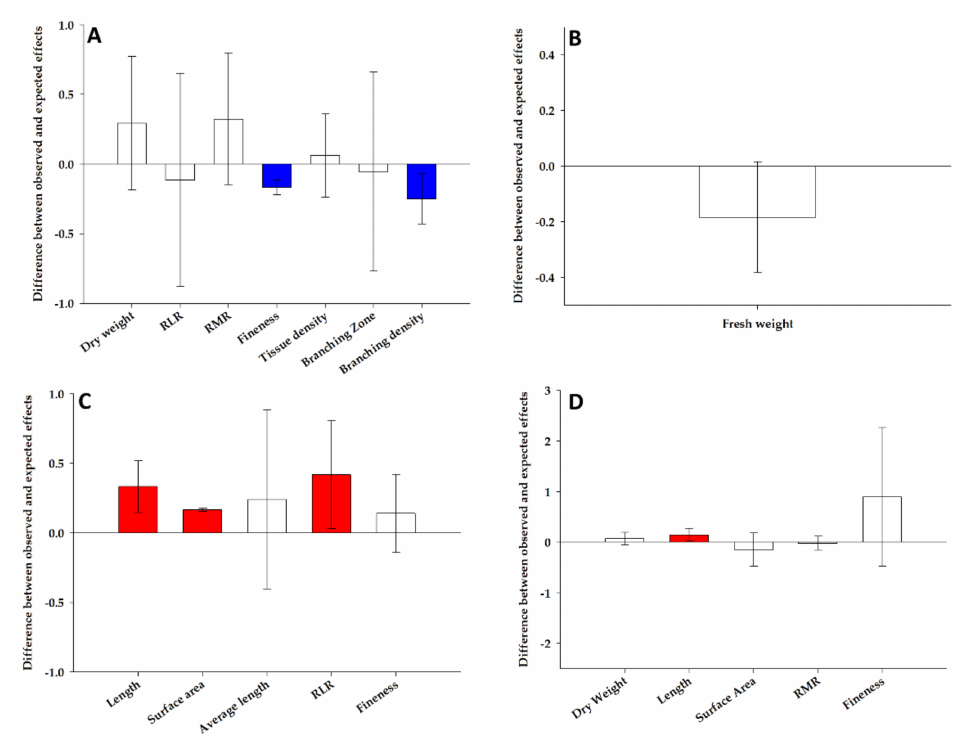
Figure 3. The combined impacts from drought and heat stress on selected traits of root primary ( A ), seminal ( B ), primary lateral ( C ) and seminal lateral ( D ) of maize plants. The combined impact of single stressors was estimated as synergist (red color), additive (white color) or antagonistic (blue color) (greater than, equal to or less than expected effects, respectively, based on single stressor effect sizes). The vertical and error bars represent, respectively, the mean and the 95% confidence intervals of the overall effect size differences between the observed and expected additive effects from combined drought and heat on the root traits of maize plants. The zero line represents the expected additive effects from combined stressors. When the means (and their 95% confidence limits) were higher than or less than the zero line, they were considered synergistic or antagonistic,